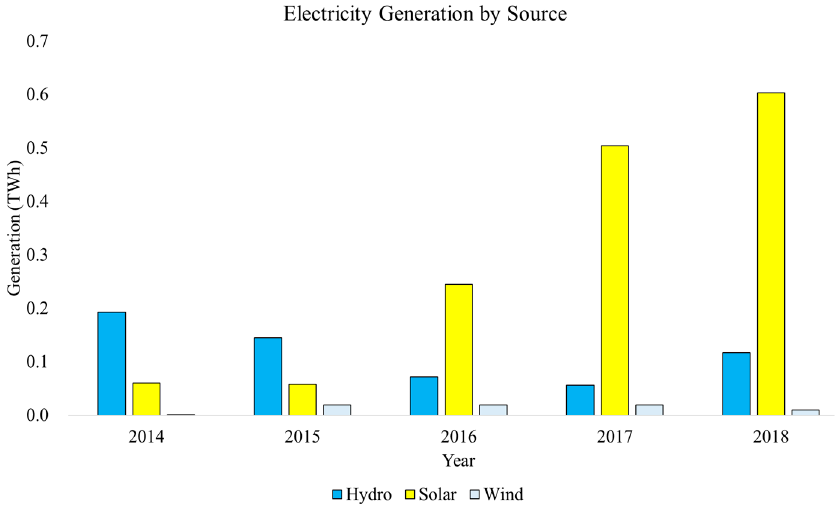
Figure 21. Algeria electricity generation by RE from 2014 to 2018.